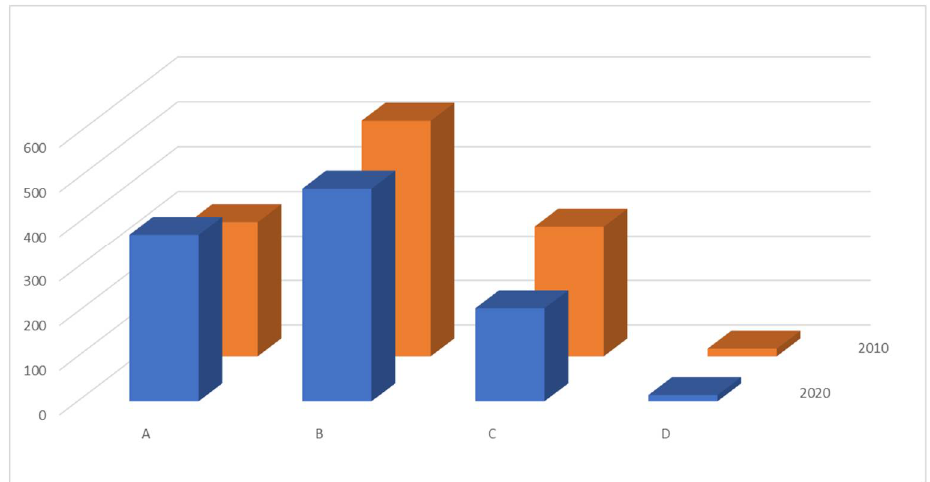
Figure 1. Decision about mode of delivery–respondents preference. A–woman’s autonomic decision B–co-decision with the obstetrician C–cesarean delivery only in case of medical indications D–non-decided respondents.